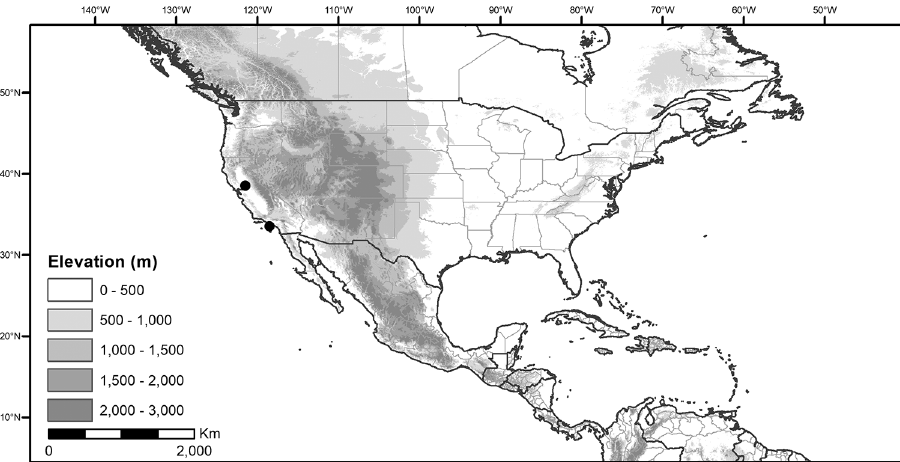
Figure 44. Distribution of Solanum retroflexum Dunal (specimens mapped are both cultivated and